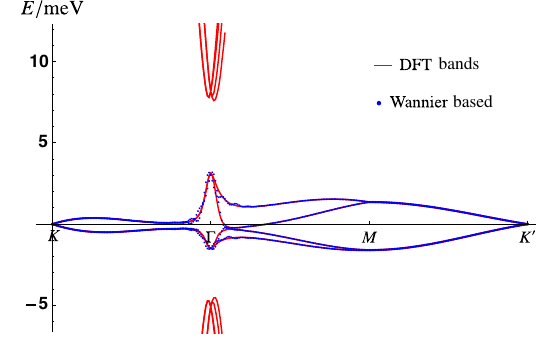
FIG. 2. Red dots: The four narrow bands produced from the tight-binding model with hopping parameters given in Ref. [20] with the twist angle of 1.30°. Blue dots: The interpolated band structure by the projection